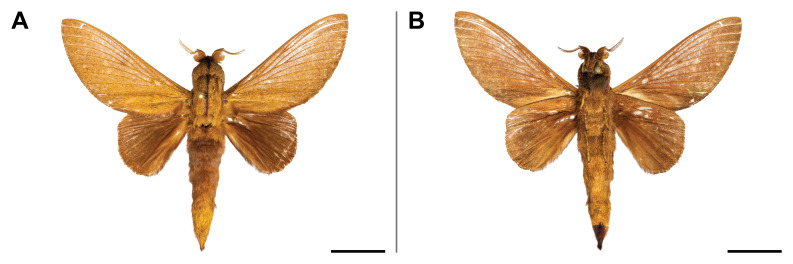
Pachytrina
gliharta Zolotuhin & Gurkovich, 2009. A. dorsal view; B. ventral view. The scale bar represents 1 cm.